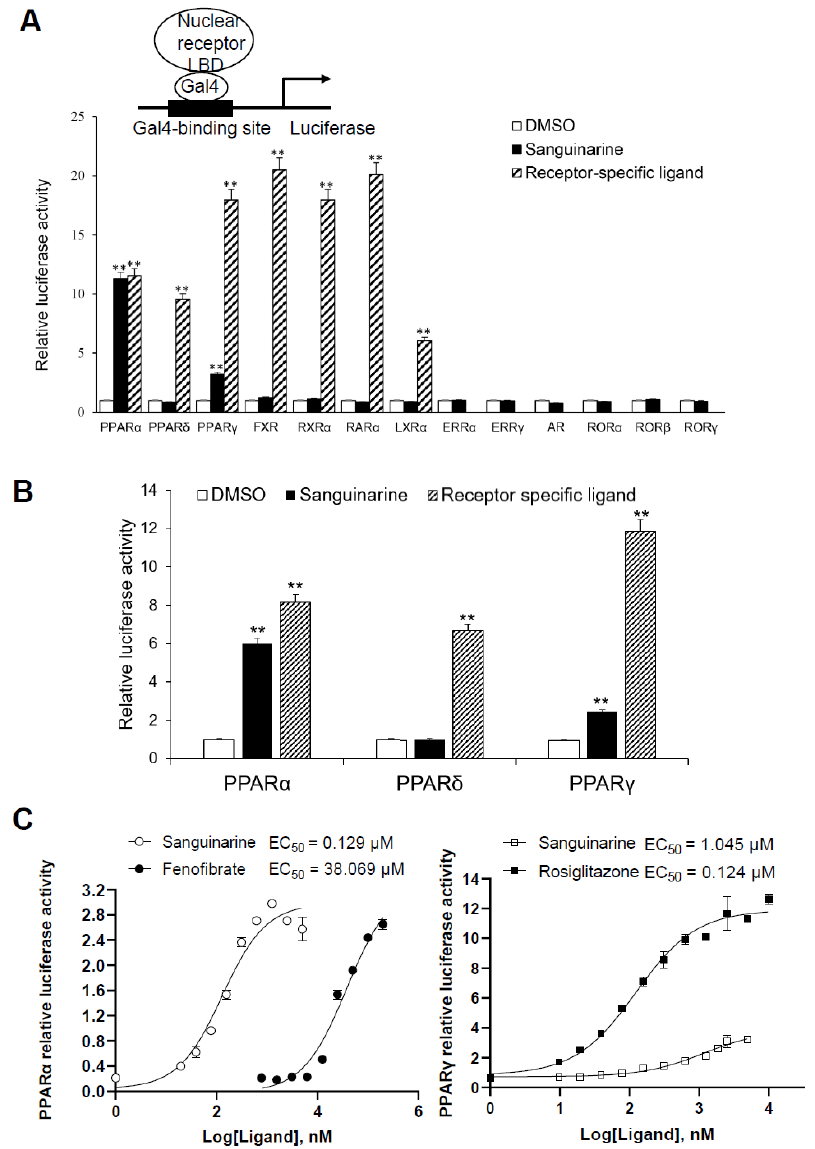
Figure 1. Identification of Sanguinarine as a dual PPAR α / γ agonist. ( A ) Receptor-specific transactivation by sanguinarine. 293T cells were co-transfected with pG5Luc reporter plasmid, together with the plasmids encoding various NR–LBDs fused with the Gal4–DNA-binding domain. After transfection, cells were treated with DMSO (white bars), 1 µ M sanguinarine (black bars), or ligands specific to each receptor (striped bars): PPAR α , 1 µ M GW590735; PPAR δ , 1 µ M GW0472; PPAR γ , 1 µ M rosiglitazone; FXR, 0.1 µ M GW4064; RXR α , 1 µ M 9 cis RA; RAR α , 1 µ M ATRA; LXR α ,1 µ M T0901317. Luciferase activity is reported as normalized to renilla activity. For clarity, ERR, estrogen-related receptor; AR, androgen receptor; ROR, retinoid-related orphan receptor. ( B ) Sanguinarine increased the expression of PPAR α / γ native promoter luciferase reporter. 293T cells were co-transfected with plasmids encoding full-length PPARs and their response element. After transfection, cells were treated with DMSO (white bars), 1 µ M sanguinarine (black bars), or ligands specific to each receptor (striped bars). ( C ) Dose responses of sanguinarine in transactivating PPAR α / γ . 293 T cells were co-transfected with plasmids encoding PPAR–LBDs fused with the Gal4–DNA-binding domain and pG5Luc reporter. After transfection, cells were treated with various concentrations of sanguinarine and specific ligands. The results equate to the average of experiments performed in triplicate, with error bars indicating SDs; ** p < 0.01, compared with